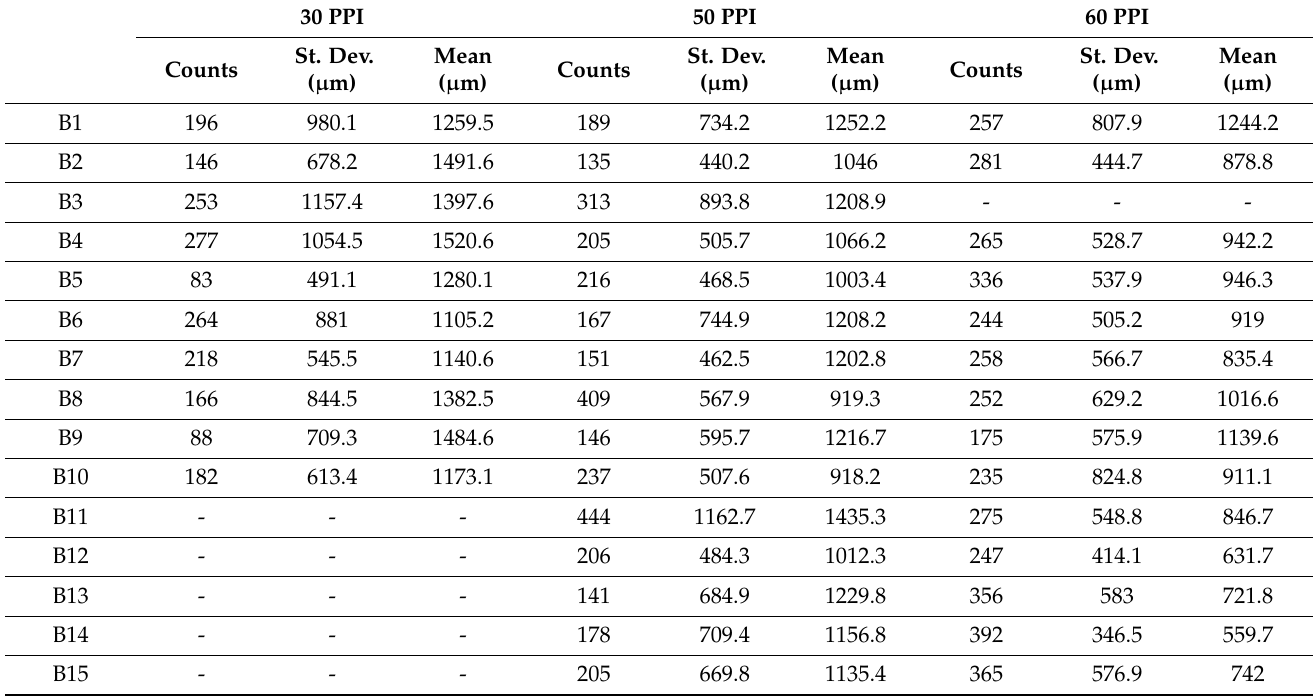
Table A11. Mean Cell ´ s Feret diameter ( d C ) of CFF samples of 30 PPI, 50 PPI and 60 PPI